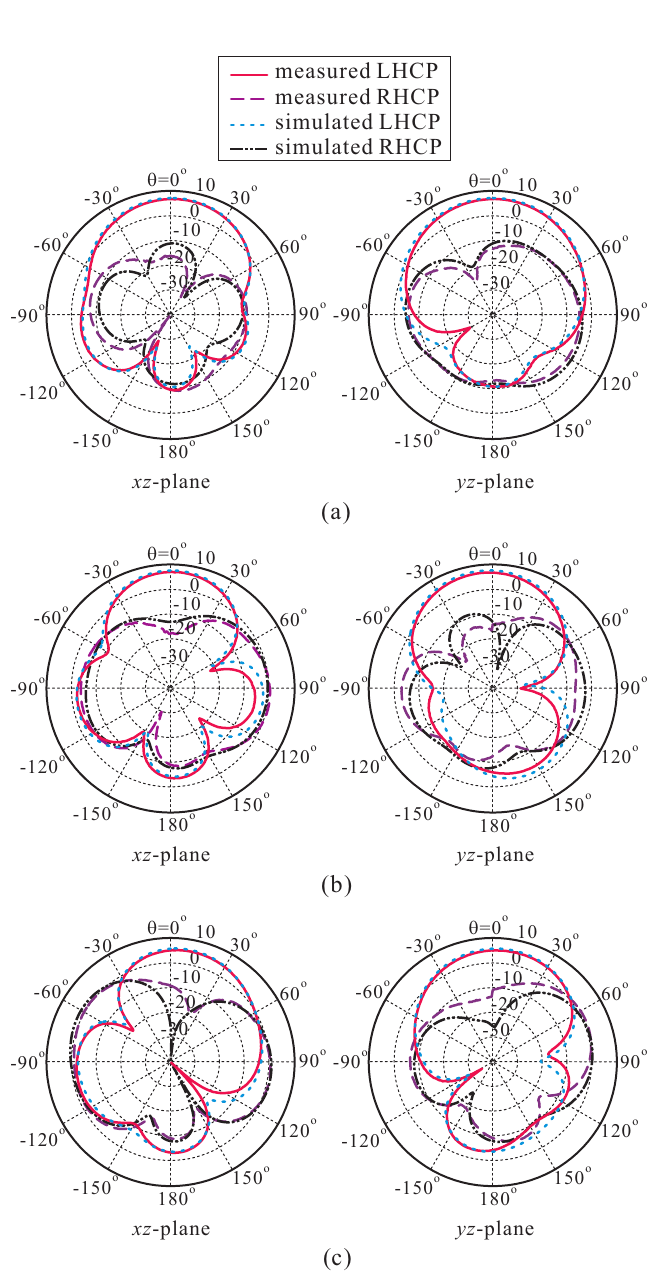
Figure 10. Measured and simulated radiation patterns of the proposed antenna at: ( a ) 2.1 GHz; ( b ) 2.3 GHz; ( c ) 2.5 GHz. RHCP: Right-handed circular